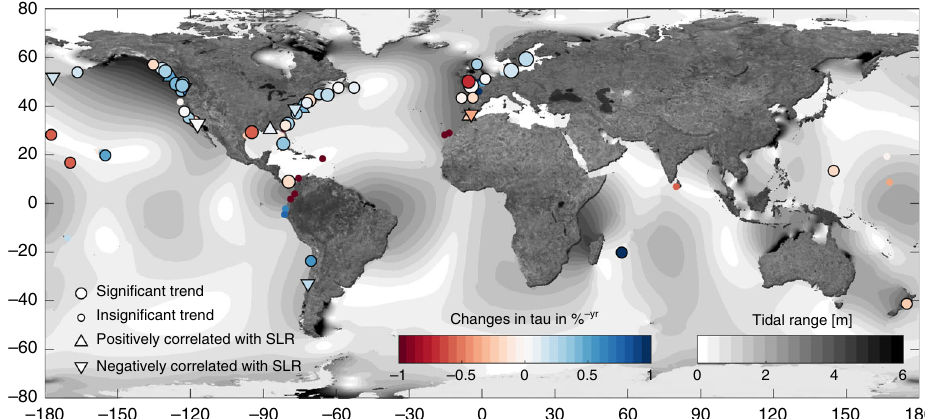
Fig. 3 Global map of temporal changes in the dependence τ . Shown are site speci fi c changes in dependence measure τ through time (at least 60 years) with increasing (blue) and decreasing (red) dependencies. Signi fi cant trends are shown as bold circles. If the changes are correlated signi fi cantly with the observed sea level rise as provided by the permanent service for mean sea level (PSMSL) database, sites are highlighted as triangles.